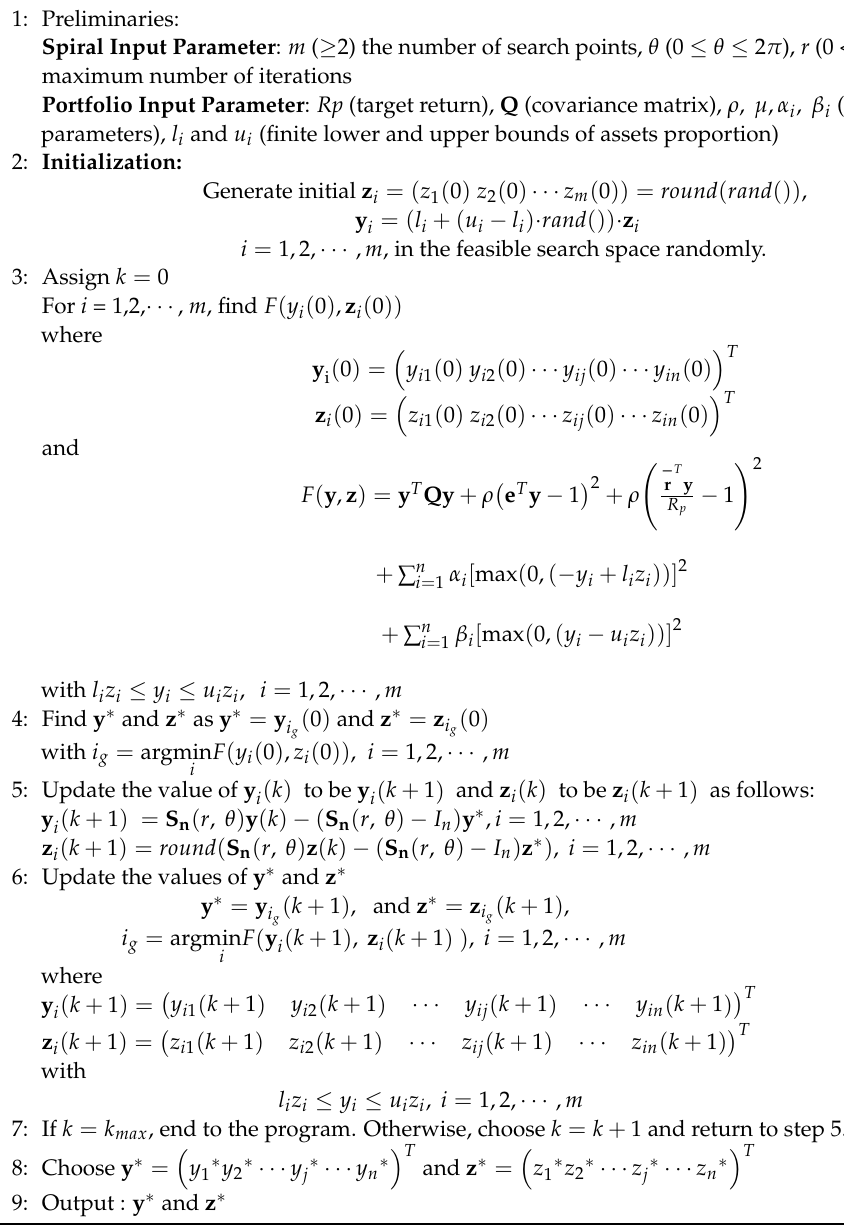
Algorithm 3. SOA for Portfolio Optimization Problem with Buy-In Threshold